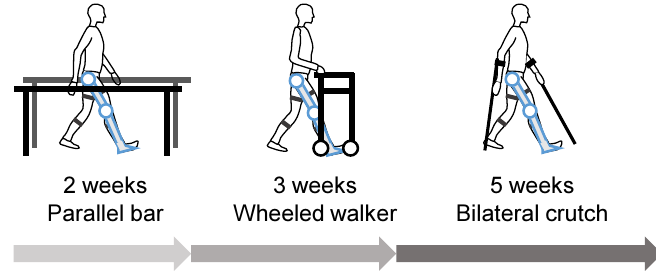
Figure 10. Robotic gait training